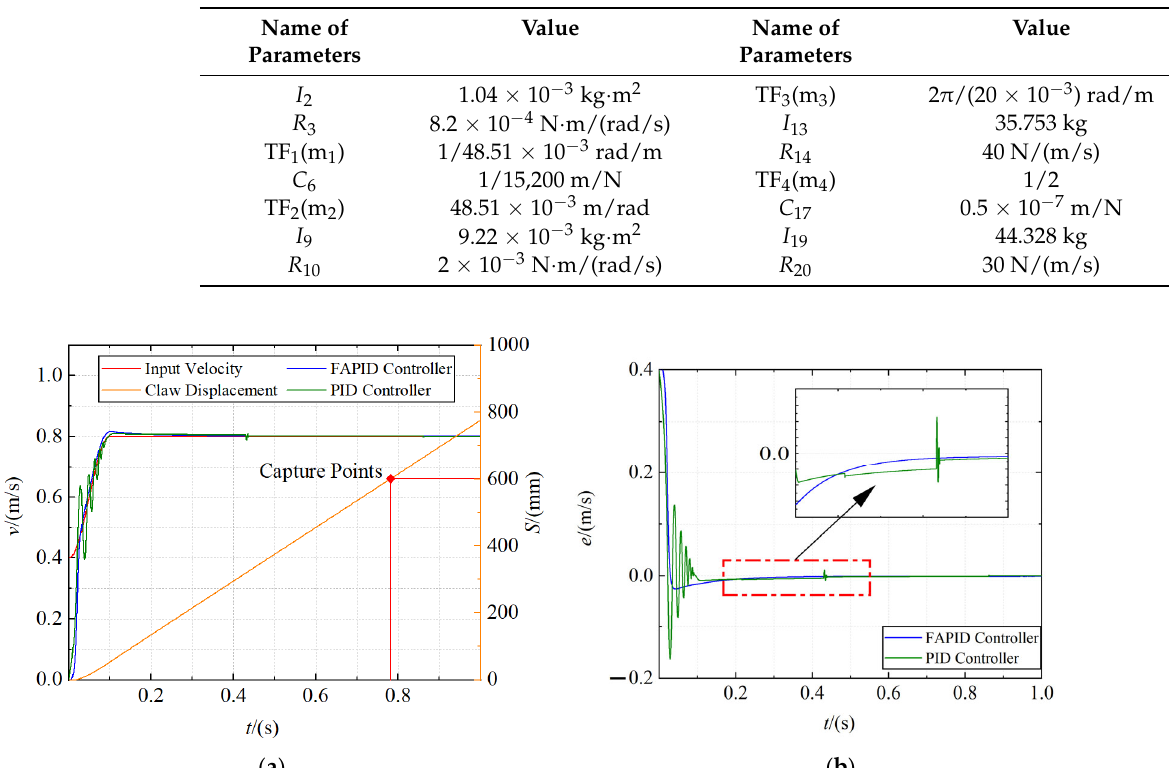
Table 5. Parameters of the capture system.